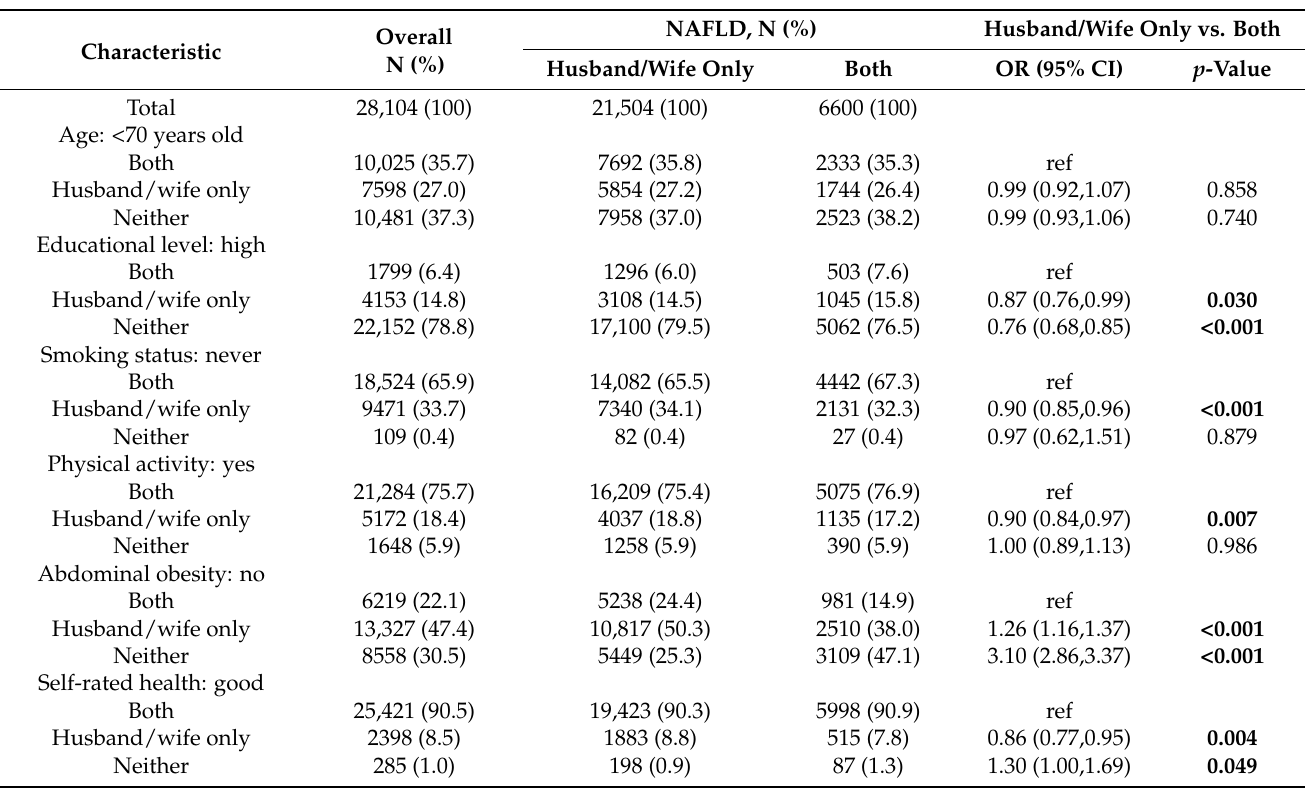
Table 4. Logistic regression for the effect of different factors on concordant NAFLD among the 28,104 older